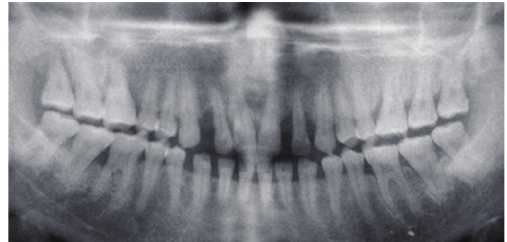
Figure 7: Orthopantomogram of the patient demonstrating gener- alized distribution of bone